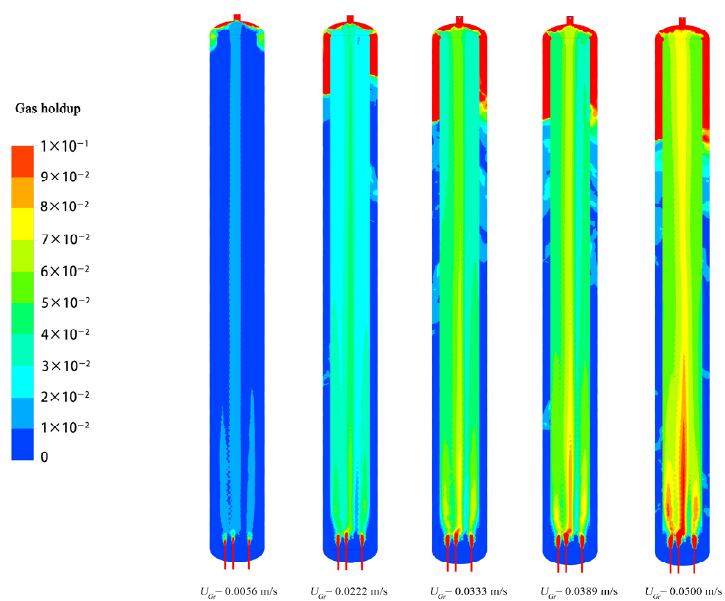
Figure 4. Evolution of gas holdup distribution with U Gr at a total column height of 15 m.